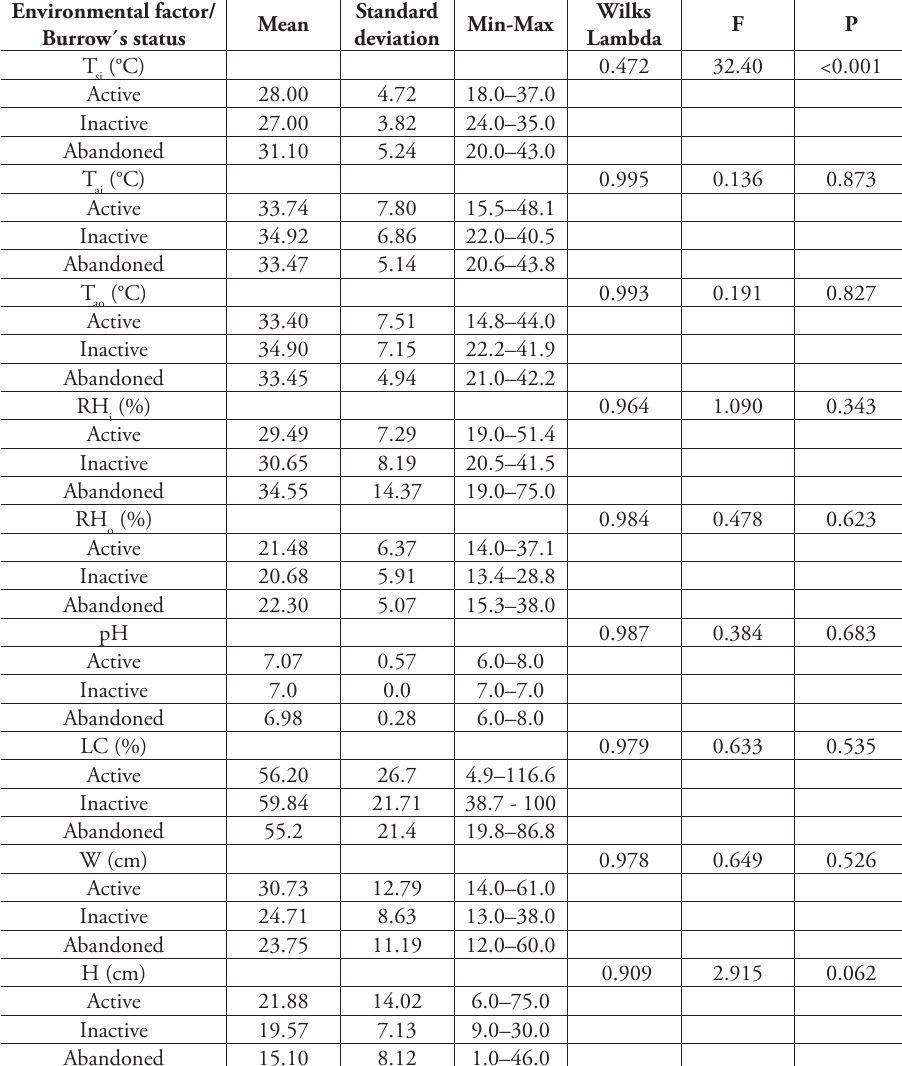
Table 1. Descriptive statistics of environmental factors for active (n = 26), inactive (n = 7), and aban- doned (n = 28) burrows, and means comparison tests among burrows categories (d.f. = 2, 58 for all cases). Air temperature inside the burrow (T ), air temperature outside (T ), relative humidity inside (RH ai ao tive humidity outside (RH ), substrate temperature inside (T o si